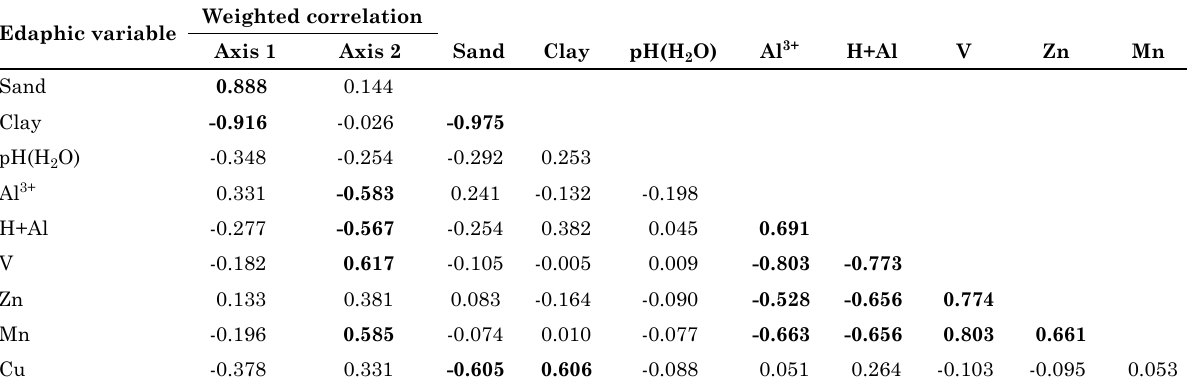
Table 3. Canonical correspondence analysis (CCA) of the abundance of 34 species sampled in 25 plots located in ouroana, municipality of Rio Verde, goiás,